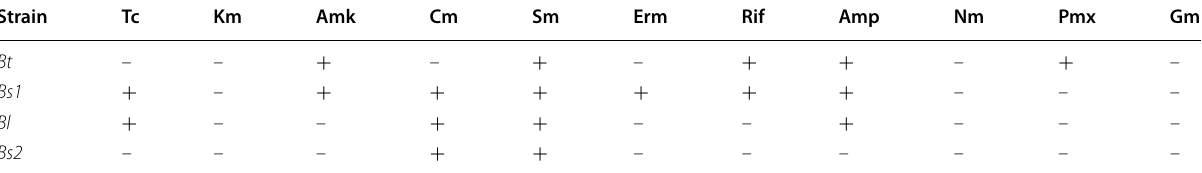
Table 2 Antibiotic resistance patterns of the four Bacillus strains; Bt (main parent); and each of Bs1, Bl and Bs2